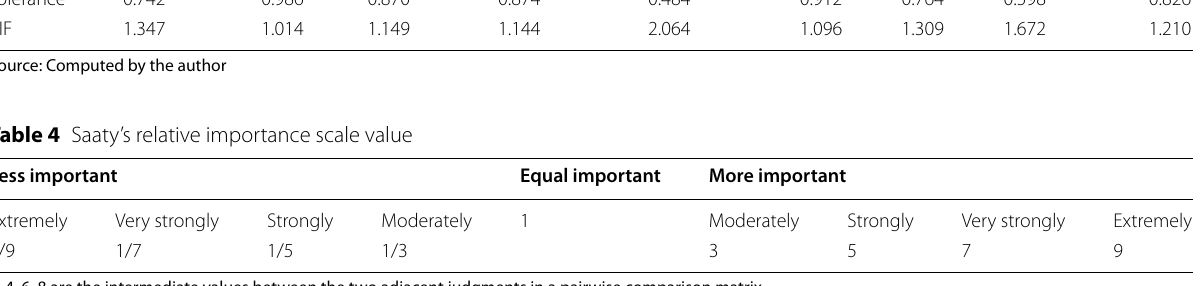
2, 4, 6, 8 are the intermediate values between the two adjacent judgments in a pairwise comparison